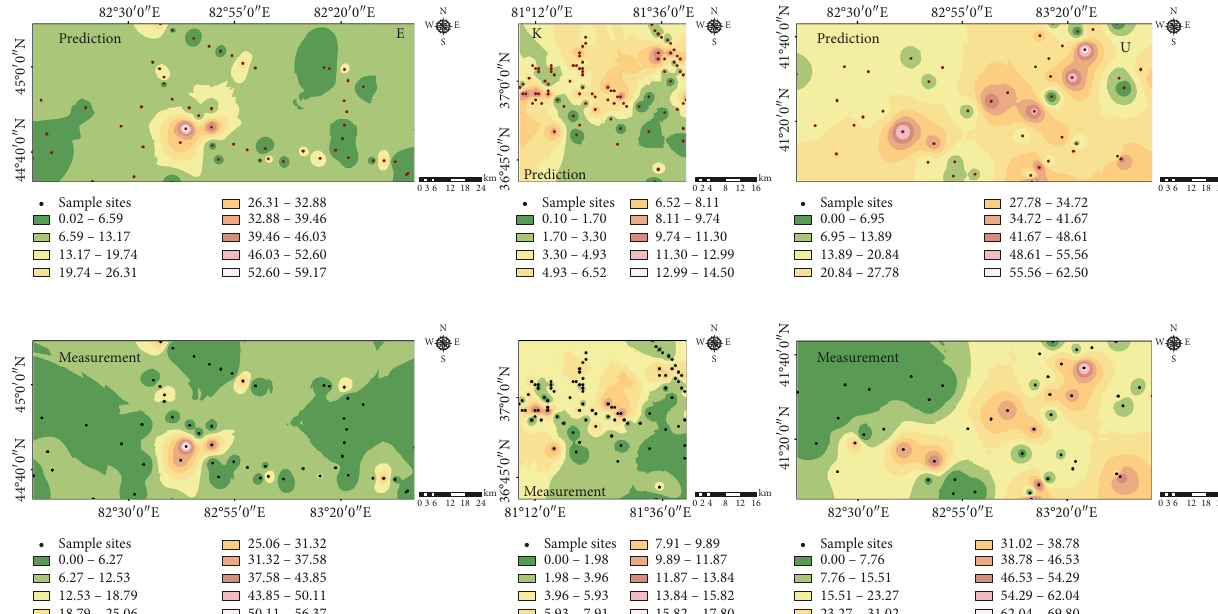
Figure 6: Comparative interpolation map of the measured and predicted values of SSC.